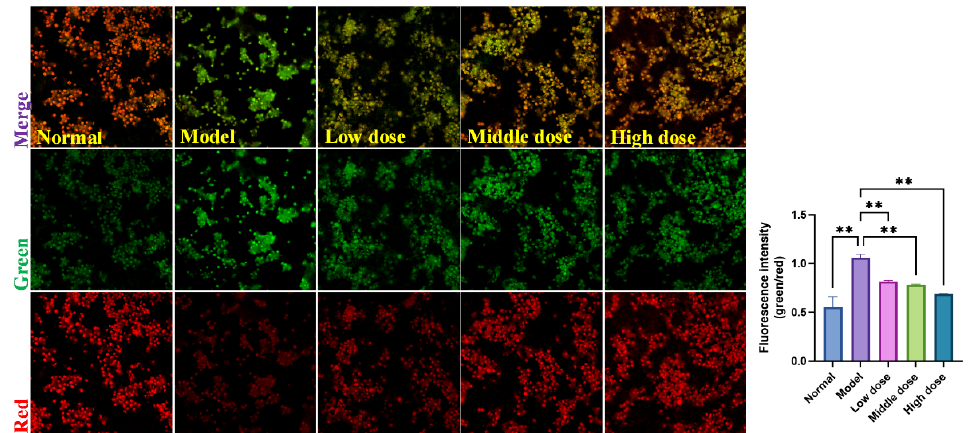
Figure 10. Effects of SMP on the ΔΨ m in PC12 cells (×20). Cells were pretreated with SMP (4%, 8%, and 16%) for 24 h and then incubated in the presence of H 2 O 2 (100 μ M) for 24 h. ΔΨ m was measured using a JC-1 assay kit and observed using laser confocal microscopy under a 20× microscope. SMP: Salvia miltiorrhiza-containing plasma. The values were represented as the mean ± SD ( n = 3). ** p < 0.01 vs. model group.